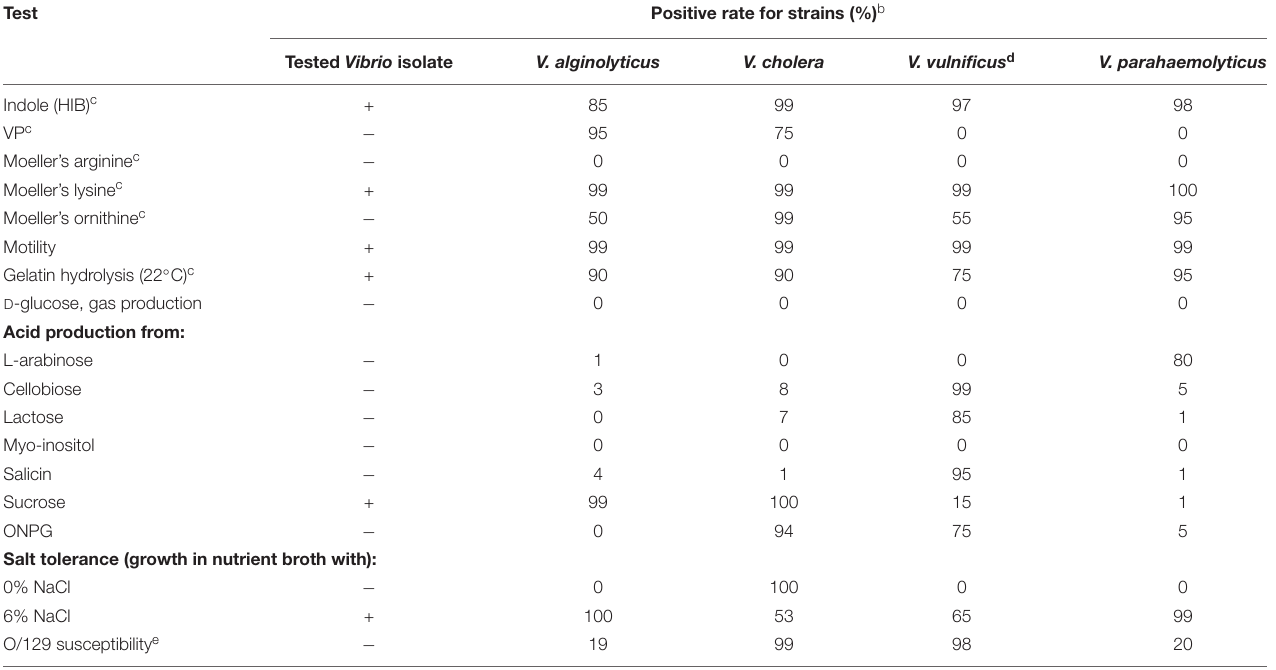
TABLE 1 | Comparison of biochemical responses between the clinical Vibrio isolate and four common pathogenic Vibrio species a . Test